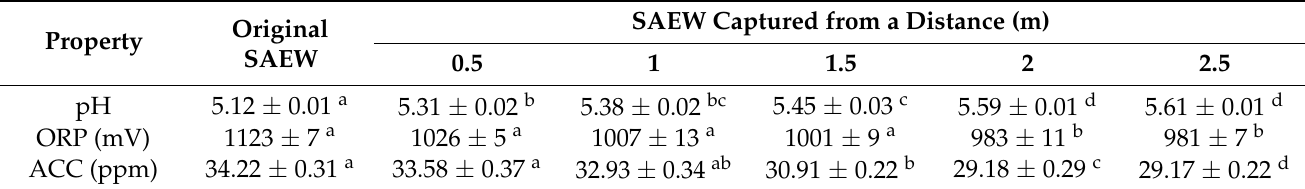
Table 3. Physicochemical properties of slightly acidic electrolyzed water samples collected after spraying. Property